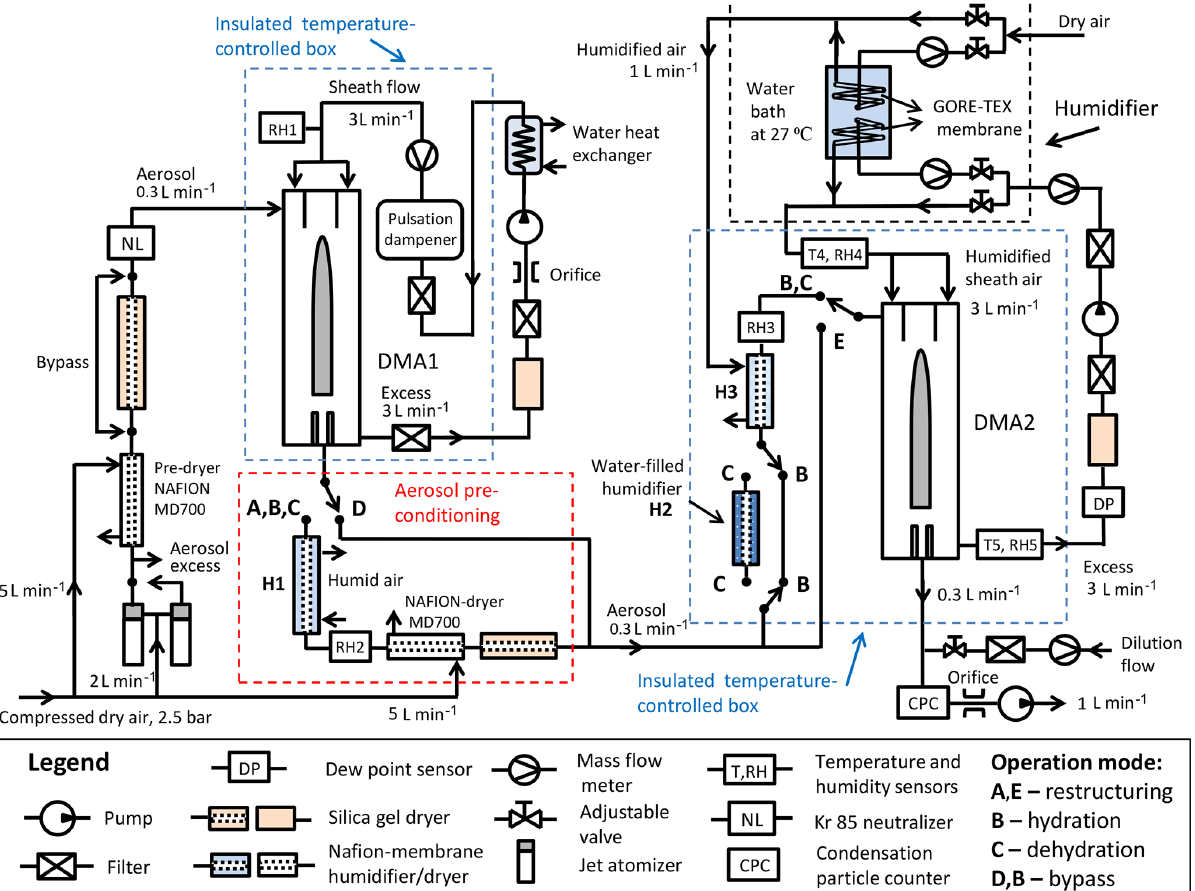
Figure 1. Schematic design of the HHTDMA setup. RH–RH5: relative humidity sensors (Almemo, FHAD 46C41A); T4, T5: needle sensors (Pt100, 1/3, 300 × 1 . 5mm, DOSTMANN electronic); DP: dew point sensor (Dew Master, Edgetech Instruments, remote D-probe SC); DMA1, DMA2: differential mobility analyzer (TSI 3081), mass flowmeter (TSI 4040), NAFION humidifier (Perma Pure; MD-110/P),